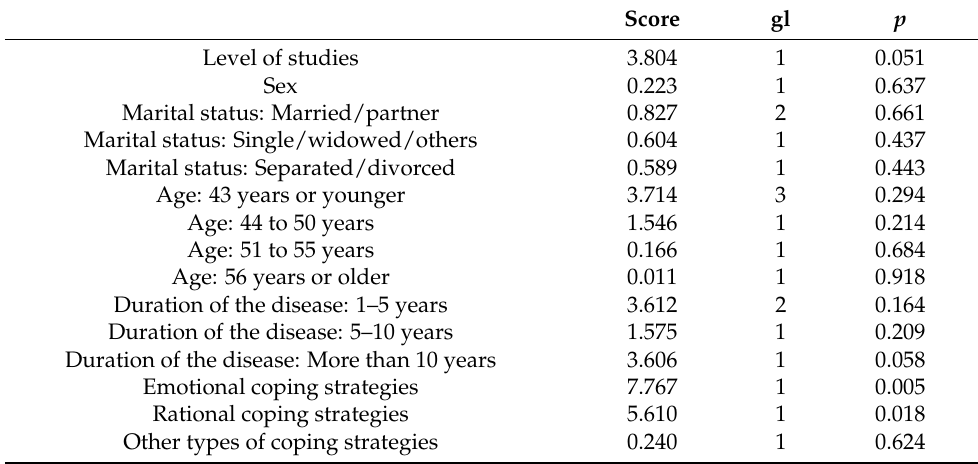
Table 3. Variables not included in the null model. HIV subjects.